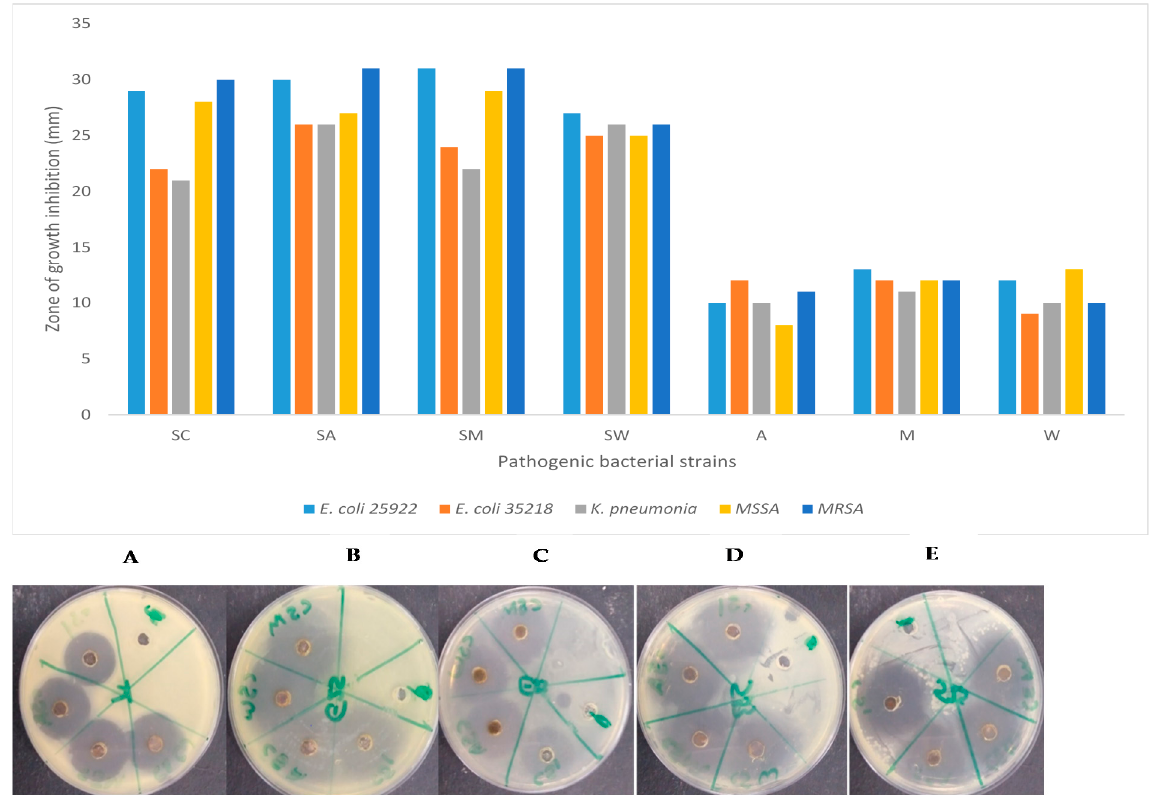
Figure 6. Antibacterial activity of P. grandiflora tuber extracts conjugated with chemically synthesized silver nanoparticles against selected bacterial strains; E. coli 25,922 ( A ), E. coli 35,218 ( B ), K. pneumonia ( C ), MSSA ( D ), MRSA ( E ). SC (Chemically synthesized silver nanoparticles), SA (Silver nanoparticles and acetone extract), SM (Silver nanoparticles and methanol extract), SW (Silver nanoparticles and water extract).